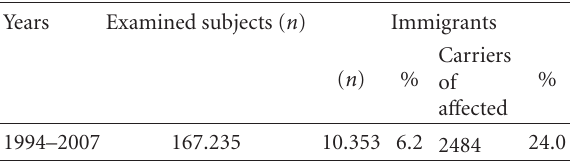
(a) Laboratory tests for provisional diagnosis (normal, anemic, iron deficient, carrier, and a ff ected individuals)